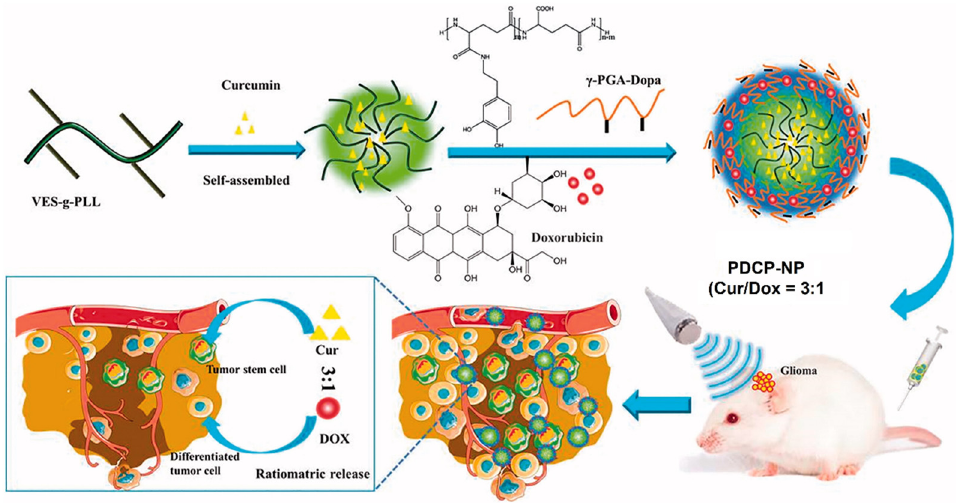
Figure 2. Schematic diagram showing the synthesis of pH-sensitive polylysine-polyglutamic acid core-shell NPs for the co-delivery of DOX and CUR to the bulk of tumor cells and CSCs in glioma. Adapted from [48] under the terms of the Creative Commons CC BY license.